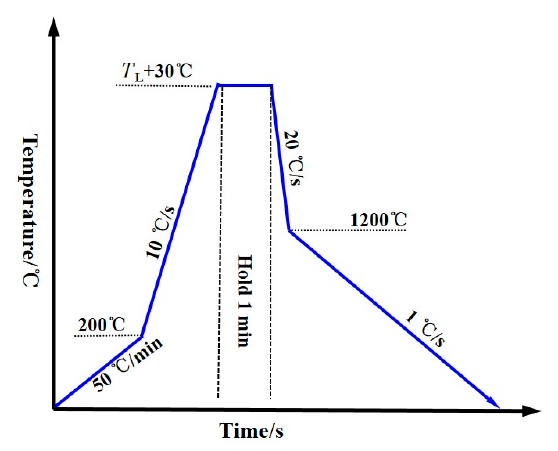
Figure 1. Thermal Figure 1. Thermal scheme.